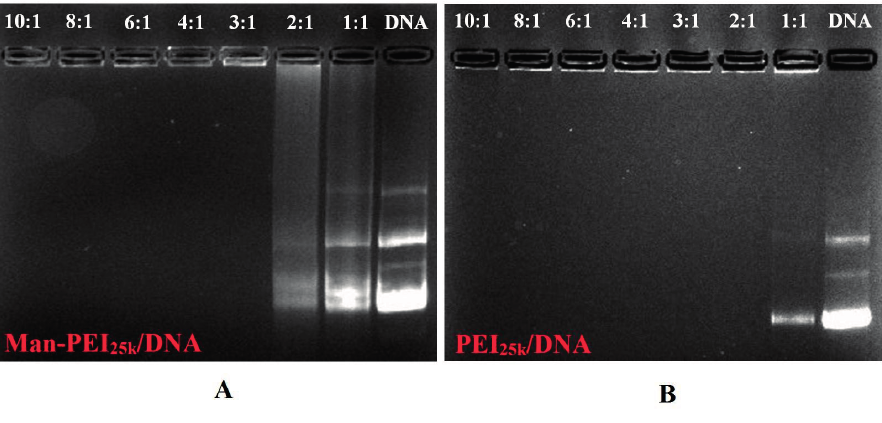
Figure 4. Agarose gel electrophoresis of different complexes at various N/P (polymer particle/DNA) ratios: ( A ) Man-PEI 25k and ( B ) PEI 25k using 1% agarose in Tris-acetate running